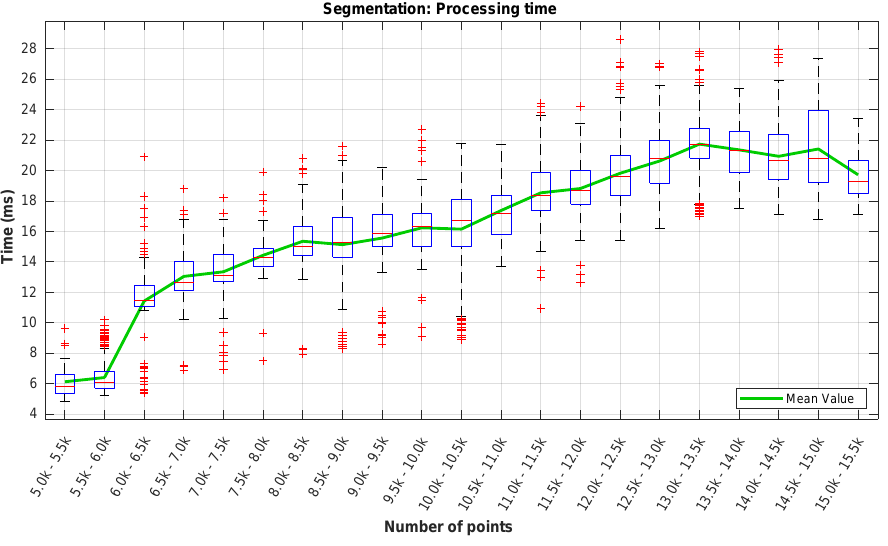
Figure 19. Processing time of the segmentation